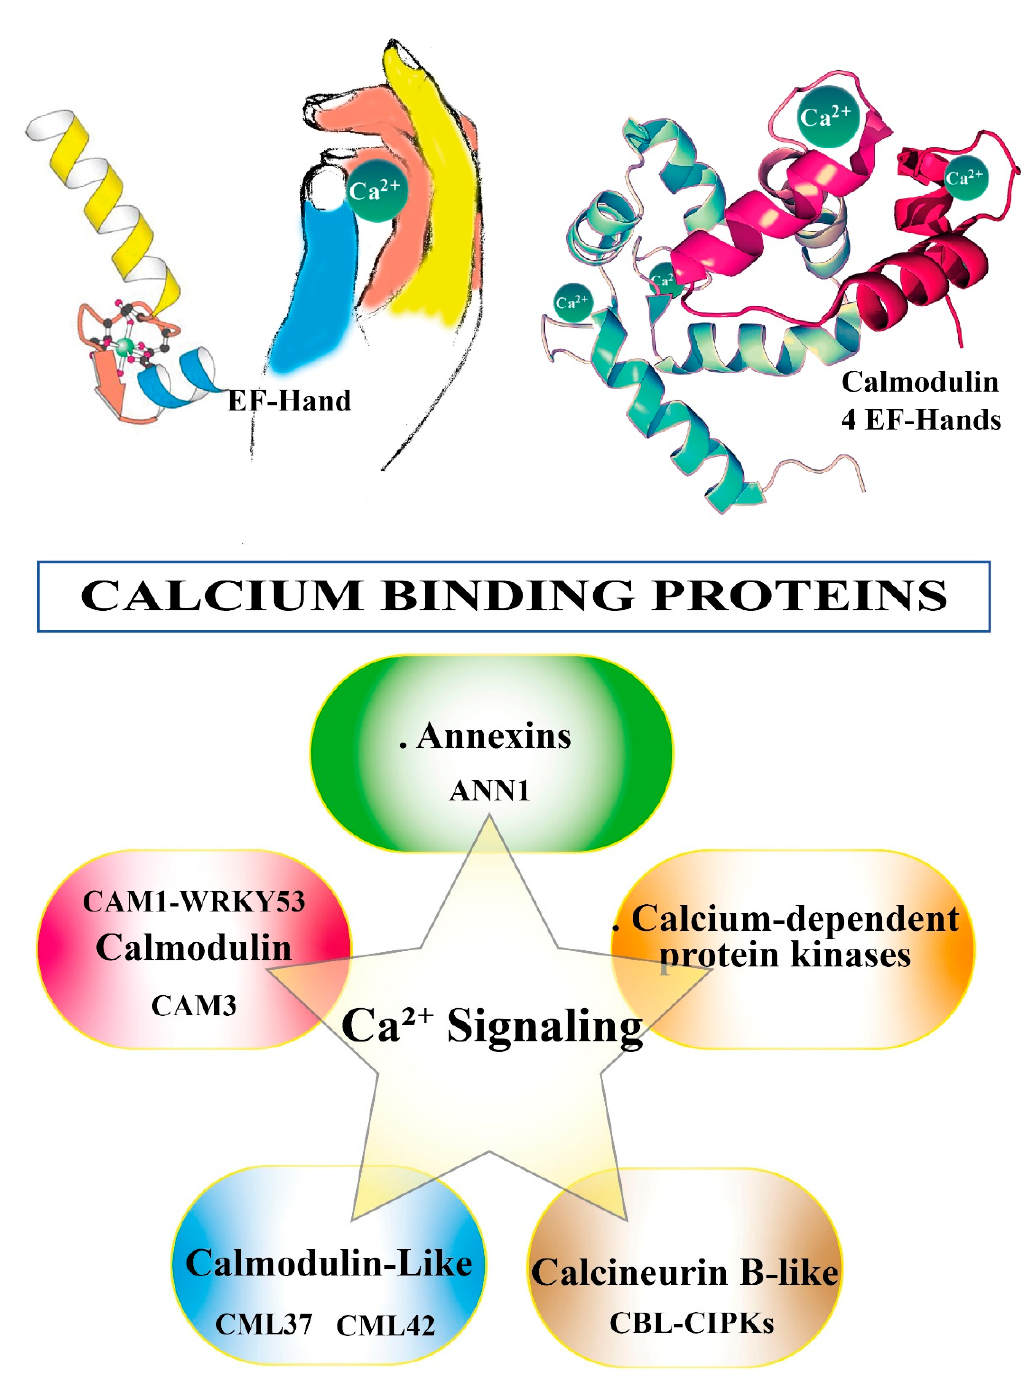
Figure 2. Calcium binding proteins. The top cartoon illustrates the canonical EF-hand helix–loop– helix. EF-hand Ca 2+ binding motif contains a 29-residue helix–loop–helix topology, much like the spread thumb and forefinger of the human hand. Calmodulin is shown with its four calcium sites (shown as green balls) occupied. Calcium binding proteins are major players in Ca 2+ signaling. See text for more details.